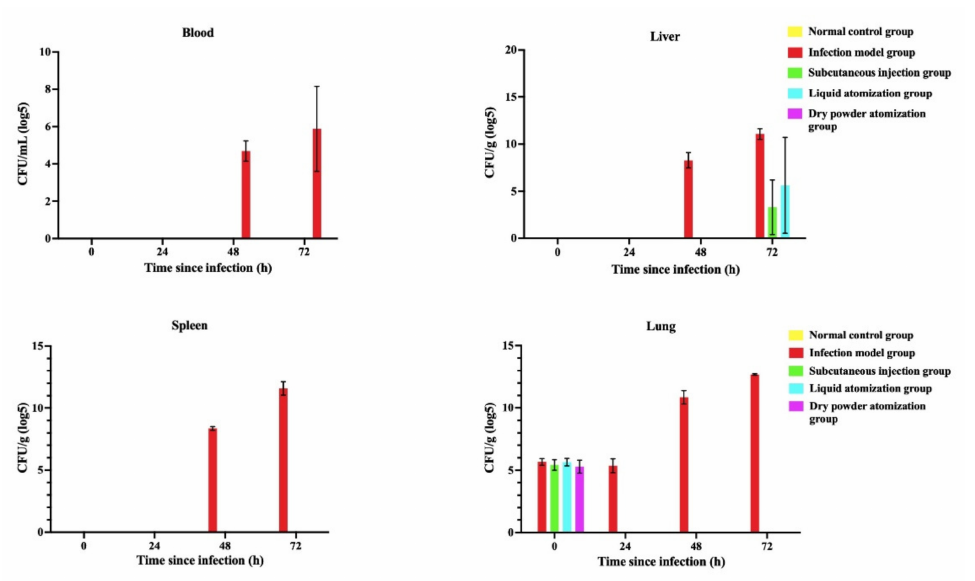
Figure 6. Bacterial loads in the blood, liver, spleen, and lungs of mice at different sampling time points.